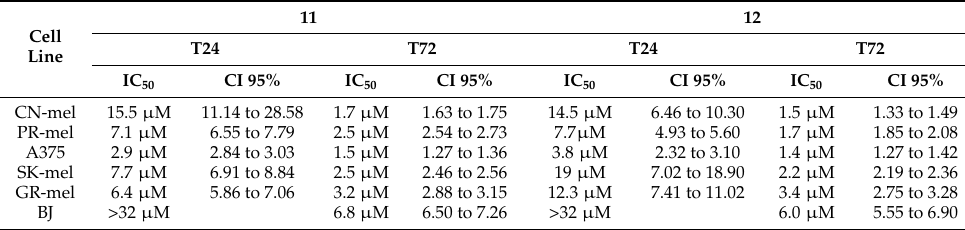
Table 1. IC 50 values for 11 and 12 . The concentrations of compounds 11 and 12 that induced a 50% cell growth inhibition (IC 50 ) after 24 h (T24) and 72 h (T72) are listed in the table with their respective 95% confidence intervals (CI). Values were estimated by a nonlinear regression of the variable slope (four parameters) model